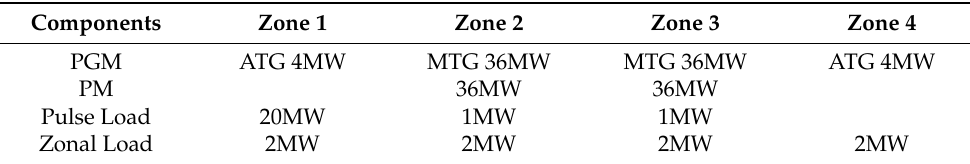
Table 1. Components specification in benchmark SPS.